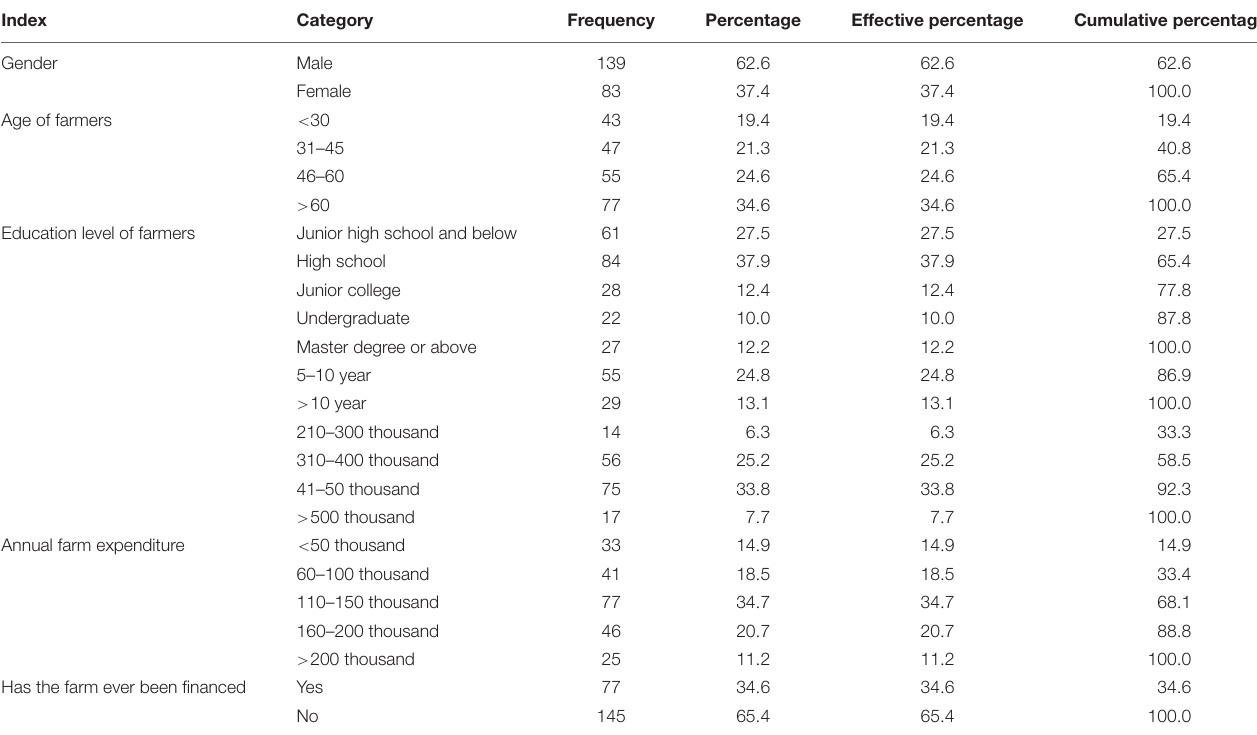
TABLE 1 | Basic information of farmers